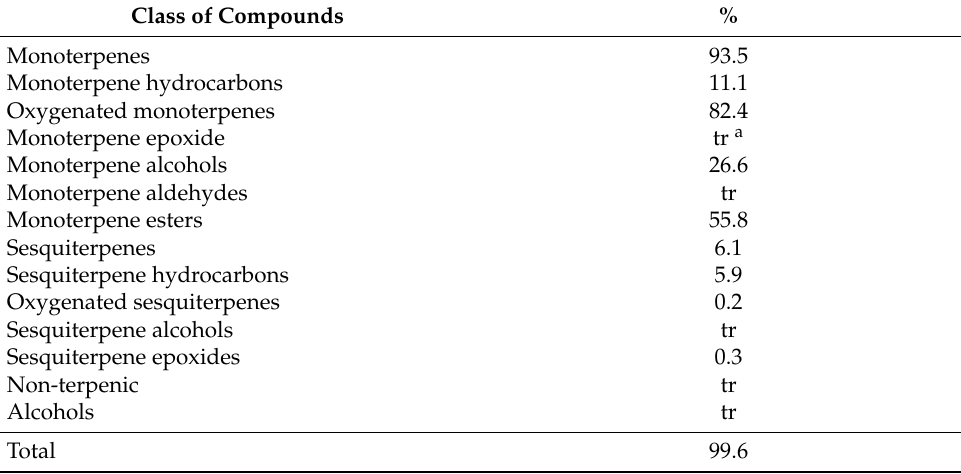
Table 2. Percentage composition of each class of identified